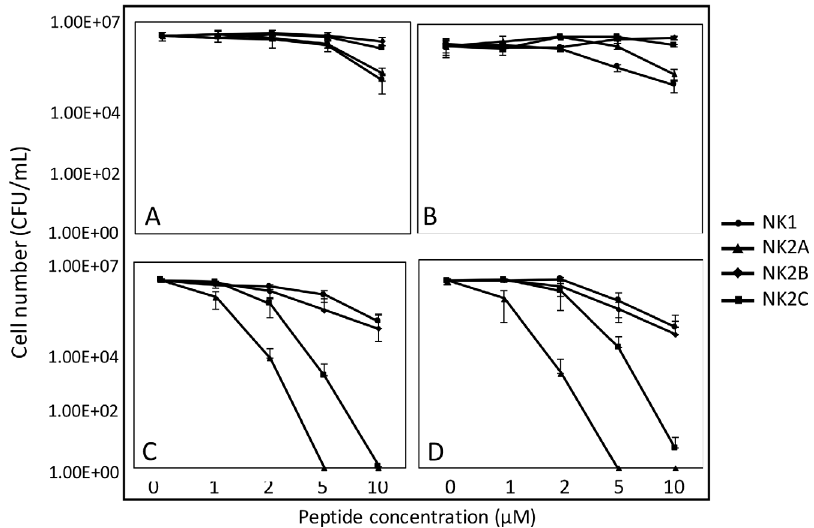
Fig 4. Antimicrobial effects of bovine NK-lysin peptides on BRD-causing pathogens P . multocida strains ATCC 43019 (A) and ATCC 43137 (B), M . haemolytica strains ATCC BAA-410 (C) and ATCC 33396 (D). Surviving cell numbers after peptide treatment are shown on the Y axis. Error bars represent the standard deviations calculated from four biological replications.